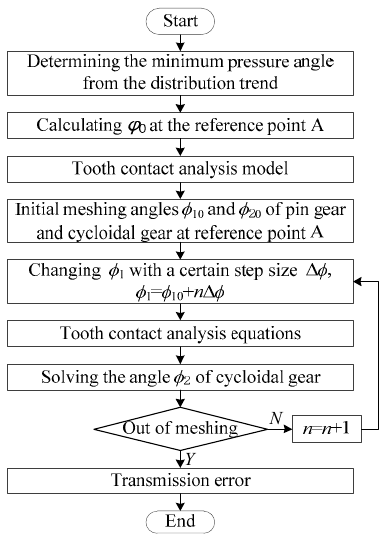
Figure 8. Process of solving the transmission error.